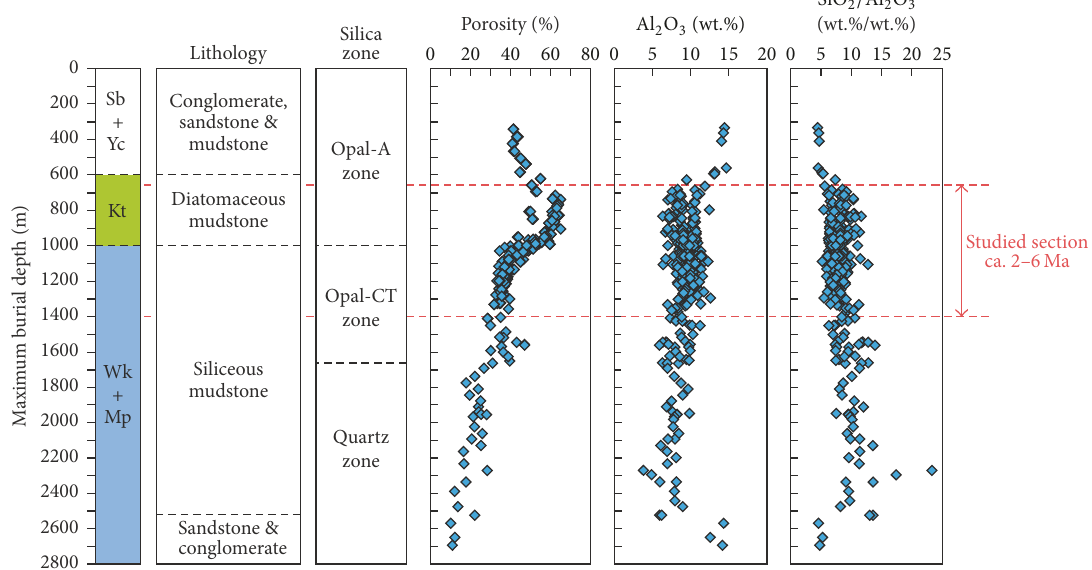
Figure 2: Geological column and variations in porosity and bulk chemical composition with maximum burial depth. Sb, Yc, Kt, Wk, and Mp indicate the Sarabetsu, Yuchi, Koetoi, Wakkanai, and Masuporo formations, respectively. The age of the studied section is based on FT ages of intercalated tuff beds reported by Ishii et al. [27]. Porosity and bulk chemistry data are from Ishii et al. [22] and Tsuji and Yokoi [26].